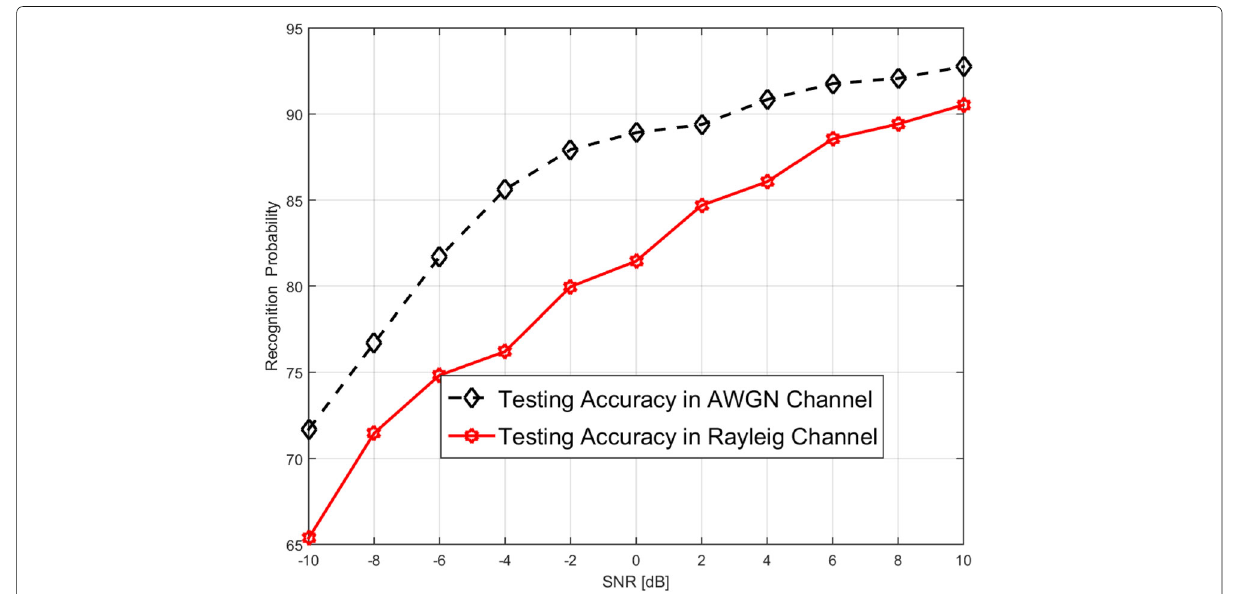
Fig. 3 φ 2 in the AWGN and Rayleigh fading channel